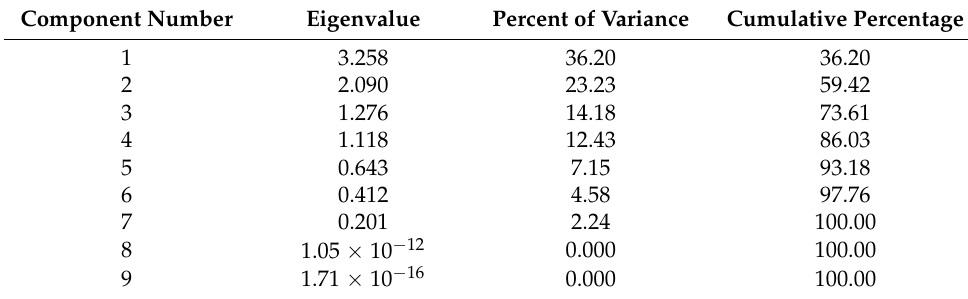
Table 4. Principal Components Analysis.